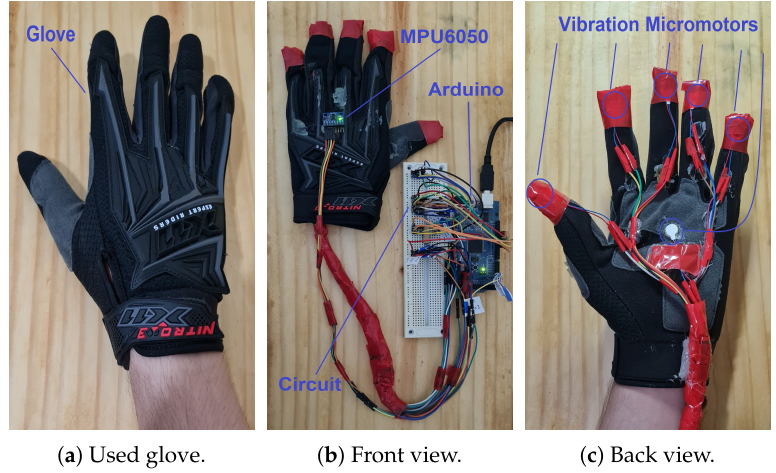
Figure 2. Tactile glove ( master device ).